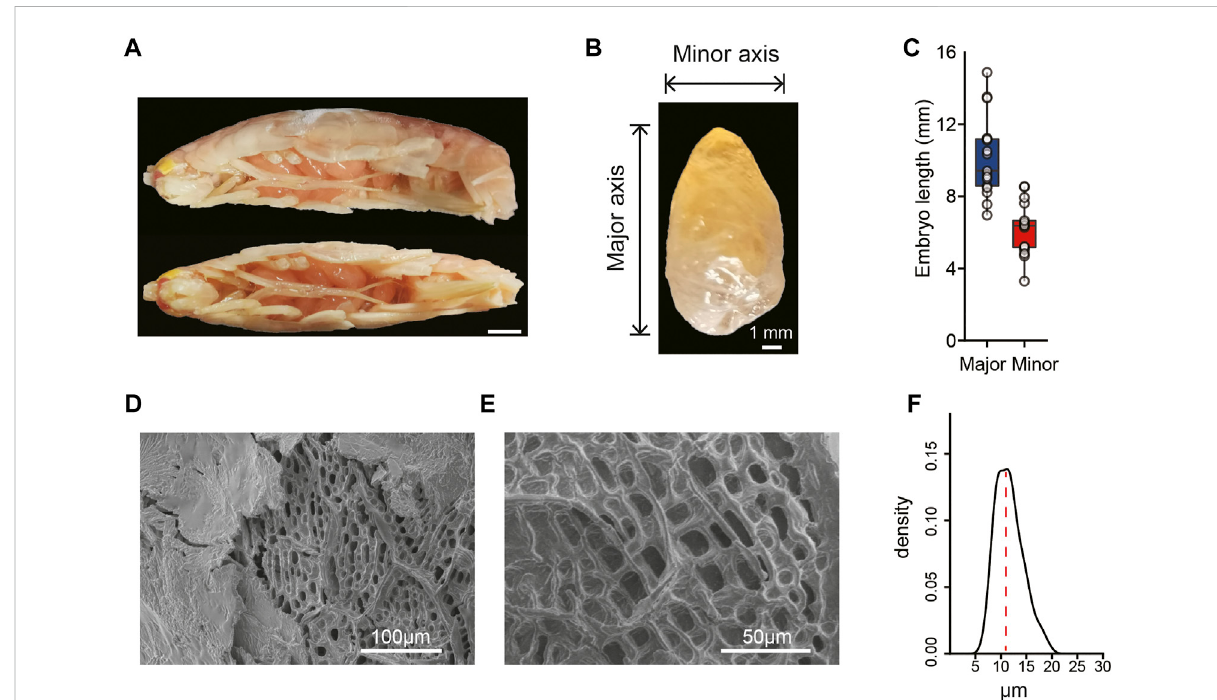
FIGURE 1 Morphological characteristics of the hadal A. gigantea ’ s eggs. (A) . Representative image of A. gigantea with eggs (lateral view and vertical view). Scale bar = 10 mm; (B) . The image of one A. gigantea egg. Horizontal and vertical line segments indicate the minor axis and the major axis, respectively. Scale bar = 1 mm; (C) . The length of the minor and the major axis of the measured eggs. (D) and (E) . The ultrastructure of eggshell by scanning electron microscopy (SEM). Scale bar = 100 μ m in D and scale bar = 50 μ m in E; (F) . The density of the hole diameter in the endochorion of the A. gigantea ’ s